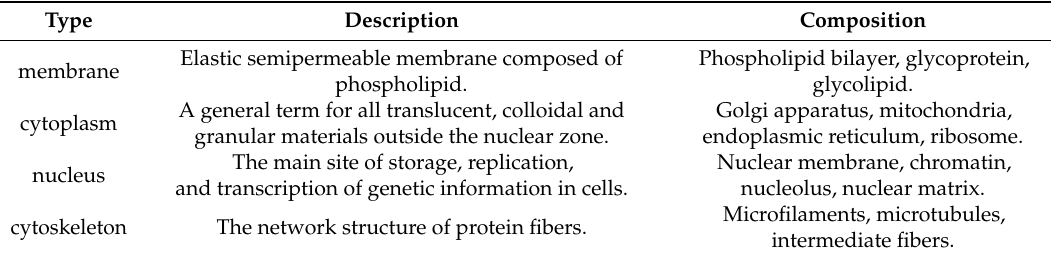
Table 1. Main components of